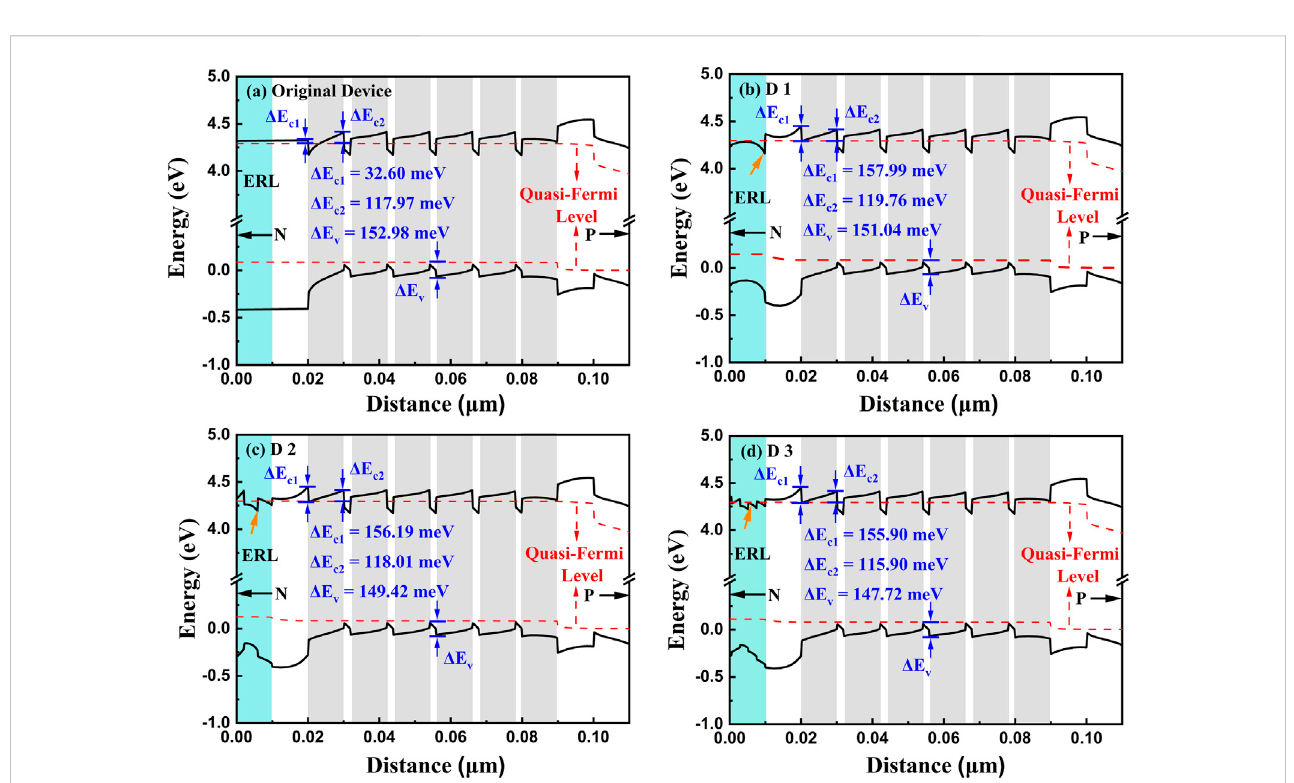
FIGURE 3 (Color online) The calculated energy band diagrams of (A) the original device, (B) D1, (C) D2, and (D) D3 at 200